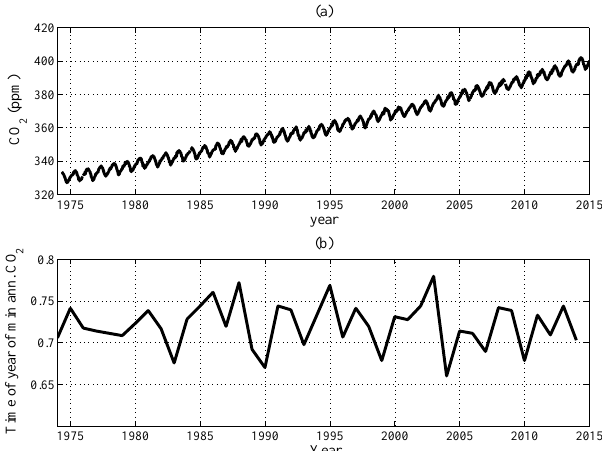
Figure 8. Atmospheric CO 2 concentration recorded at Mauna Loa against time in the upper panel. In the lower panel we have plot- ted the minimum annual CO 2 concentration against year. One no- tices the minimum CO 2 concentration occurs roughly 3 / 4 of the way through the year. This is because maximal carbon uptake oc- curs during the Northern Hemisphere summer from the terrestrial vegetation and it is maximally lagged behind the maximum in the Northern hemisphere solar insolation (best growing conditions) by 1 / 4 of a cycle because of the timescale difference between the re- sponse of the system and the period of the forcing.